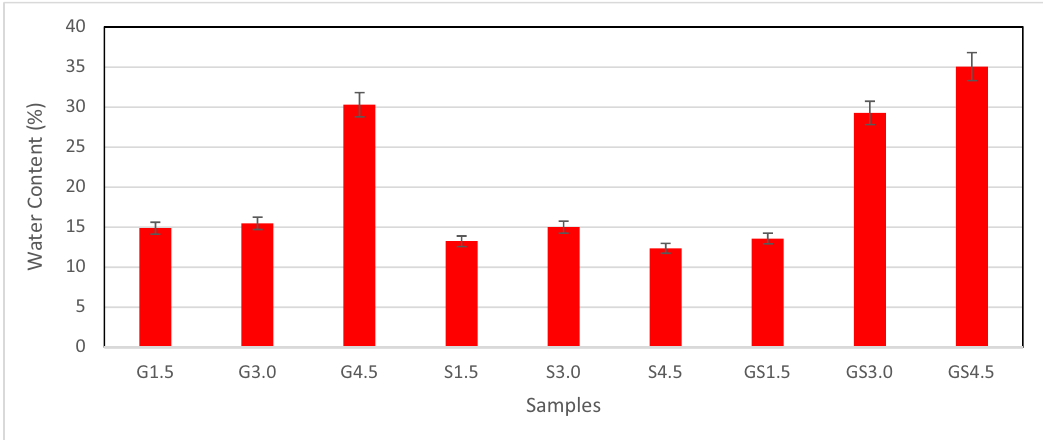
Figure 5: Water content of the samples.